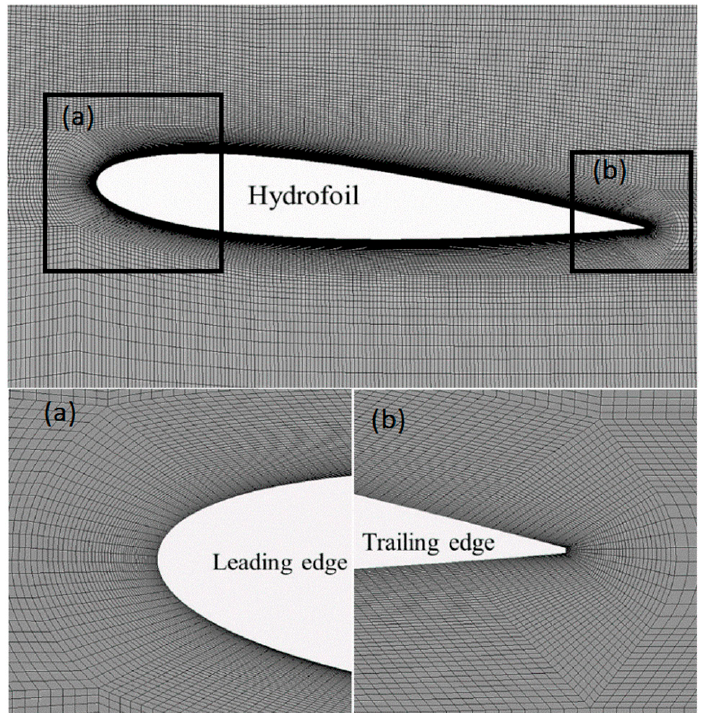
Figure 3. Mesh implementation around the hydrofoil. ( a ) Mesh around leading edge, ( b ) Mesh around trailing edge